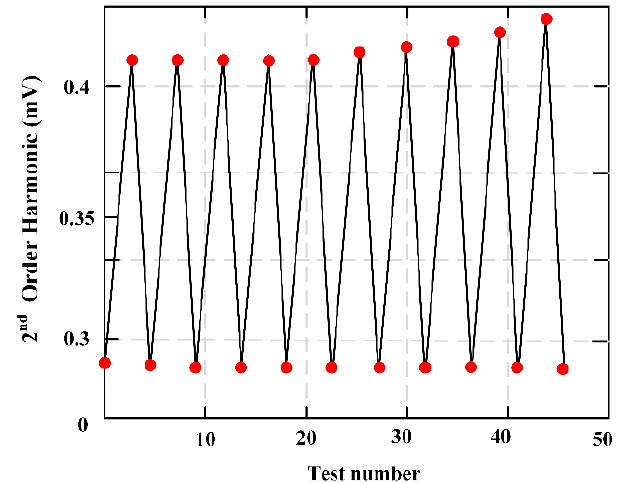
Figure 19. In the process of 10 loading cycles, the cyclic loading of the sensor ranged from 0.044 to 0.133 kN, and the results show the response drift of the sensor is very small.